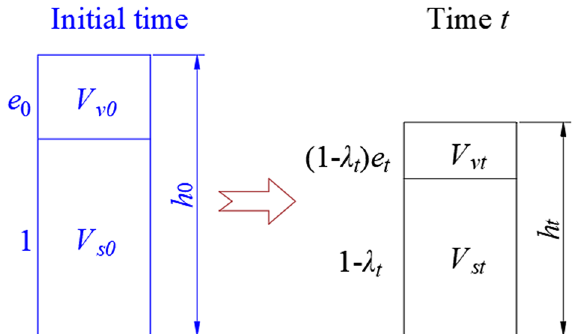
Figure 1. Schematic diagram of simplified